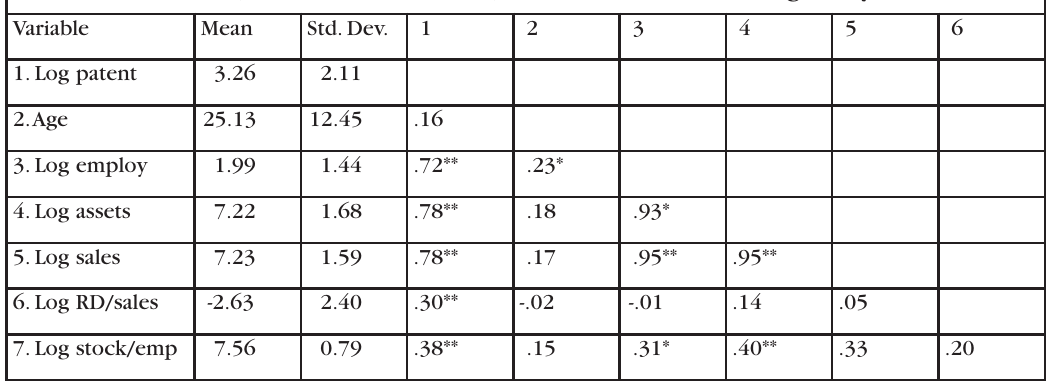
Table 1. Means, Standard Deviations, and Correlations Among Study Variables Variable Mean Std.